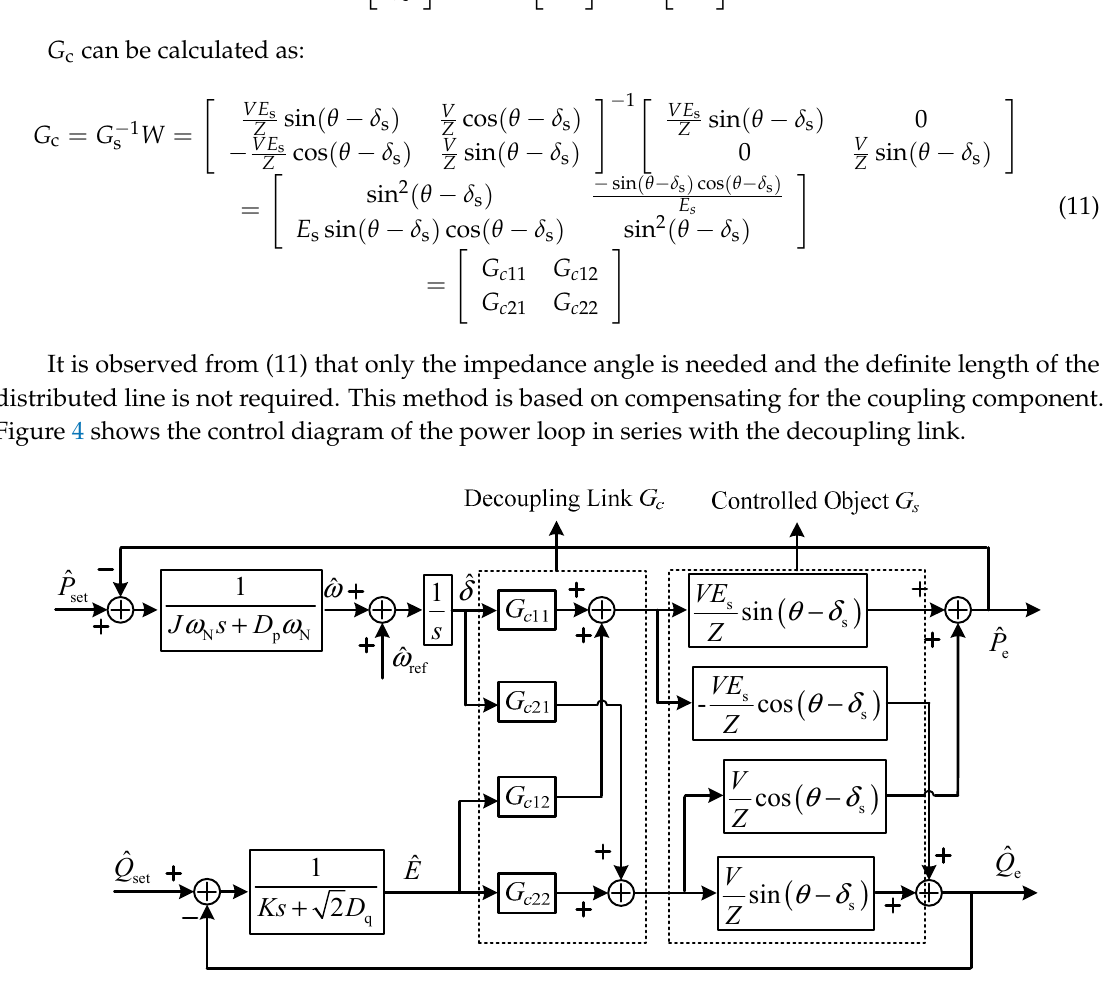
Figure 4. Control diagram of the power loop in series with the decoupling link.